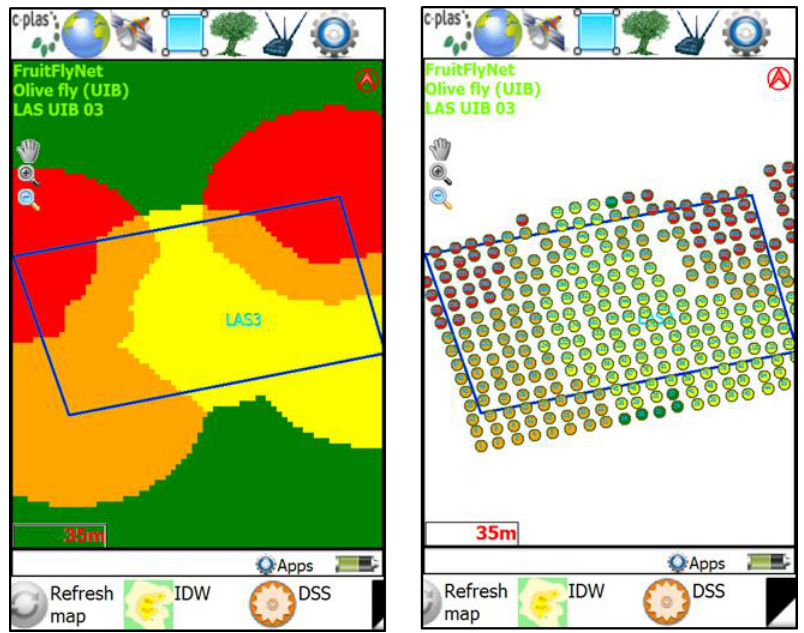
Figure 15. Screen capture of the DSS output (C-PLAS Software). Left: areas of the LAS plots that reached the threshold for insecticide treatment (red color). Right: assigned risk value per tree according to DSS